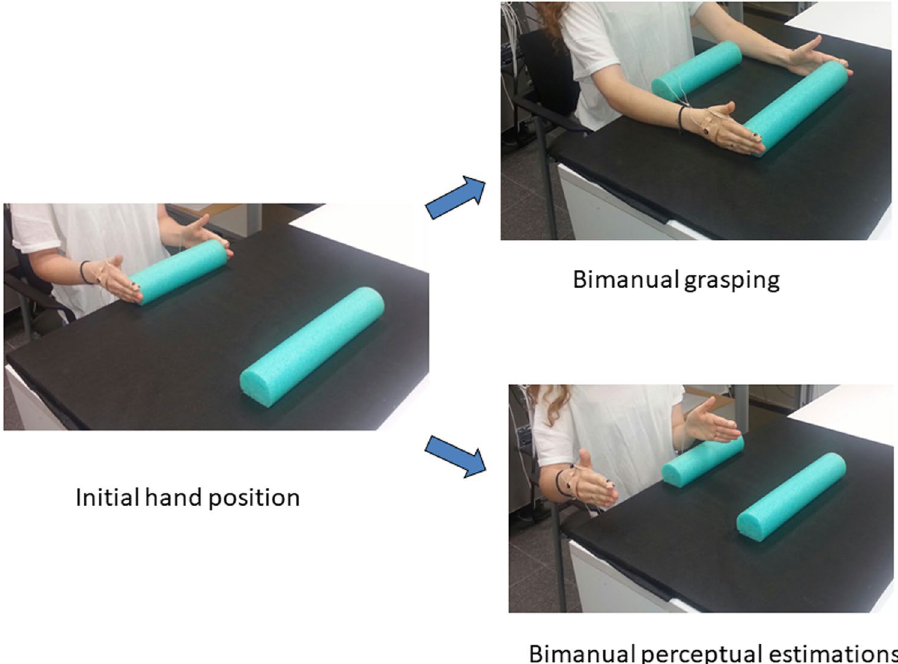
Figure 1. An illustration of the experimental design. Participants were asked to either grasp each object with both their hands (grasping condition) or to estimate its size using both their hands (perceptual estimations condition). To prevent a possible confound of hand velocity, the initial opening between the hands prior to grasping was always set to be 100 cm smaller than the size of target object 10